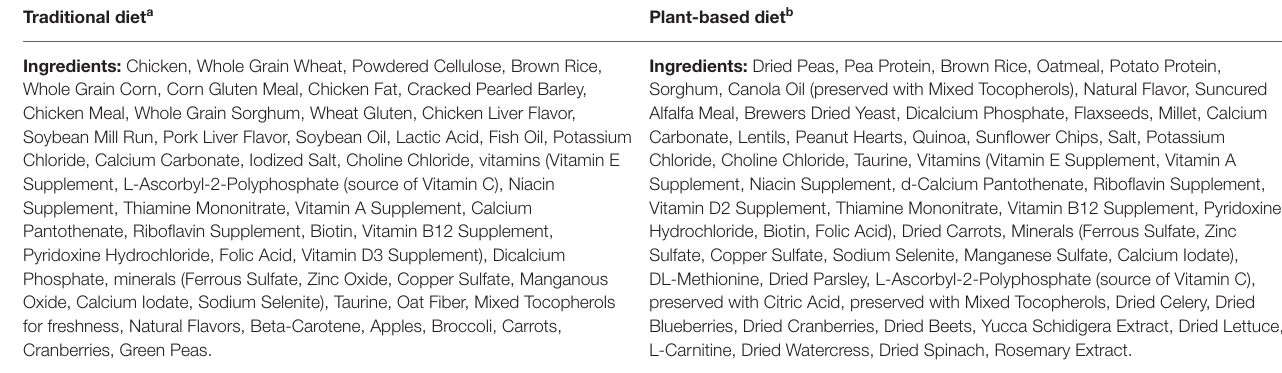
TABLE 2 | Ingredients of the traditional diet and the plant-based diet used in 16 healthy adult dogs in an AB/BA crossover study design. Traditional diet a Plant-based diet b